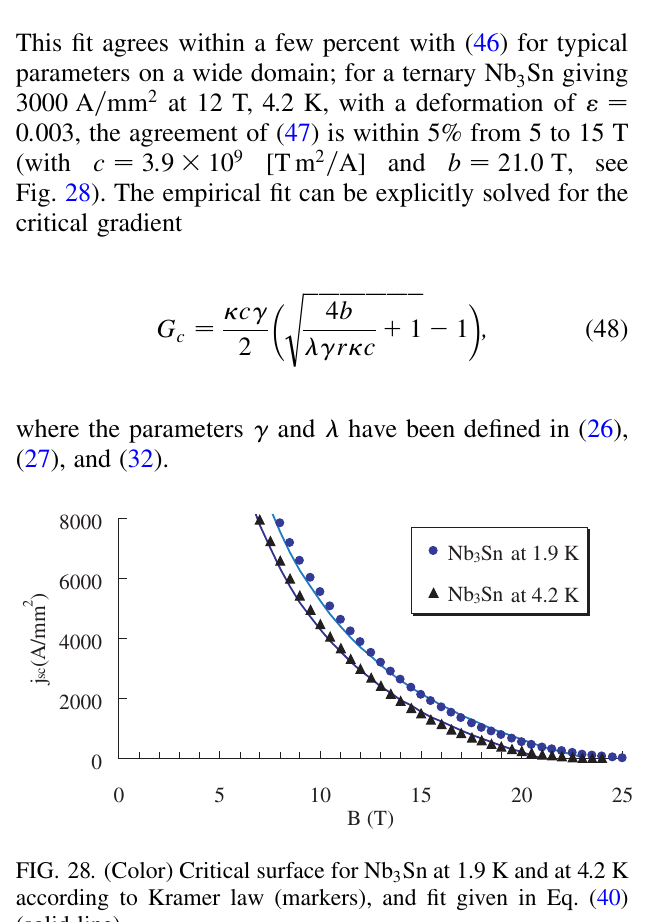
Sn at 1.9 K and at 4.2 K 3